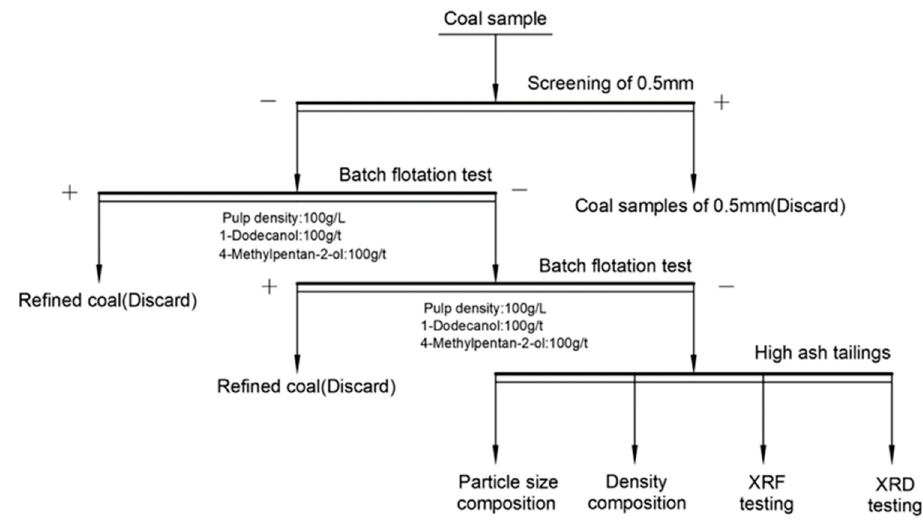
Figure 1. Coal sample processing treatment.